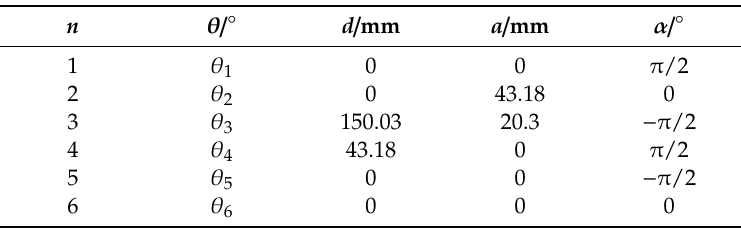
Table 16. The DH parameters of the Puma560